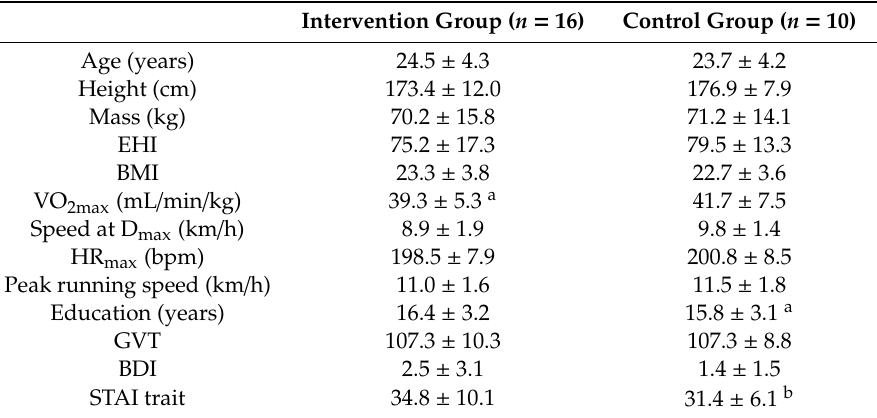
Table 1. Participants’